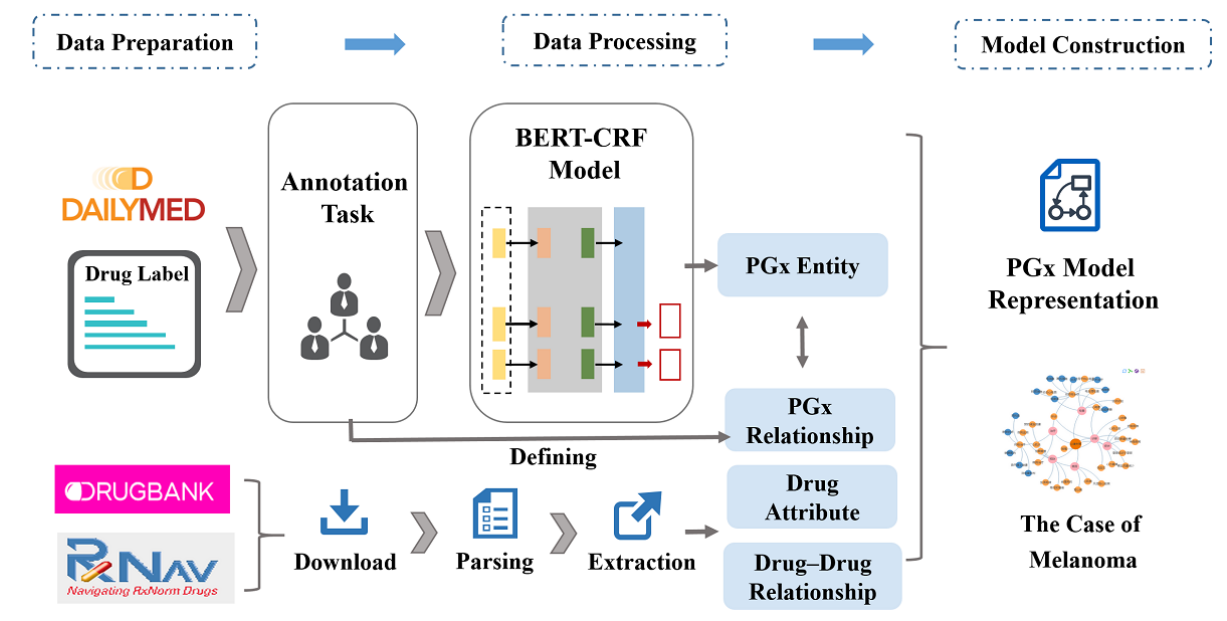
Figure 1. The framework of our